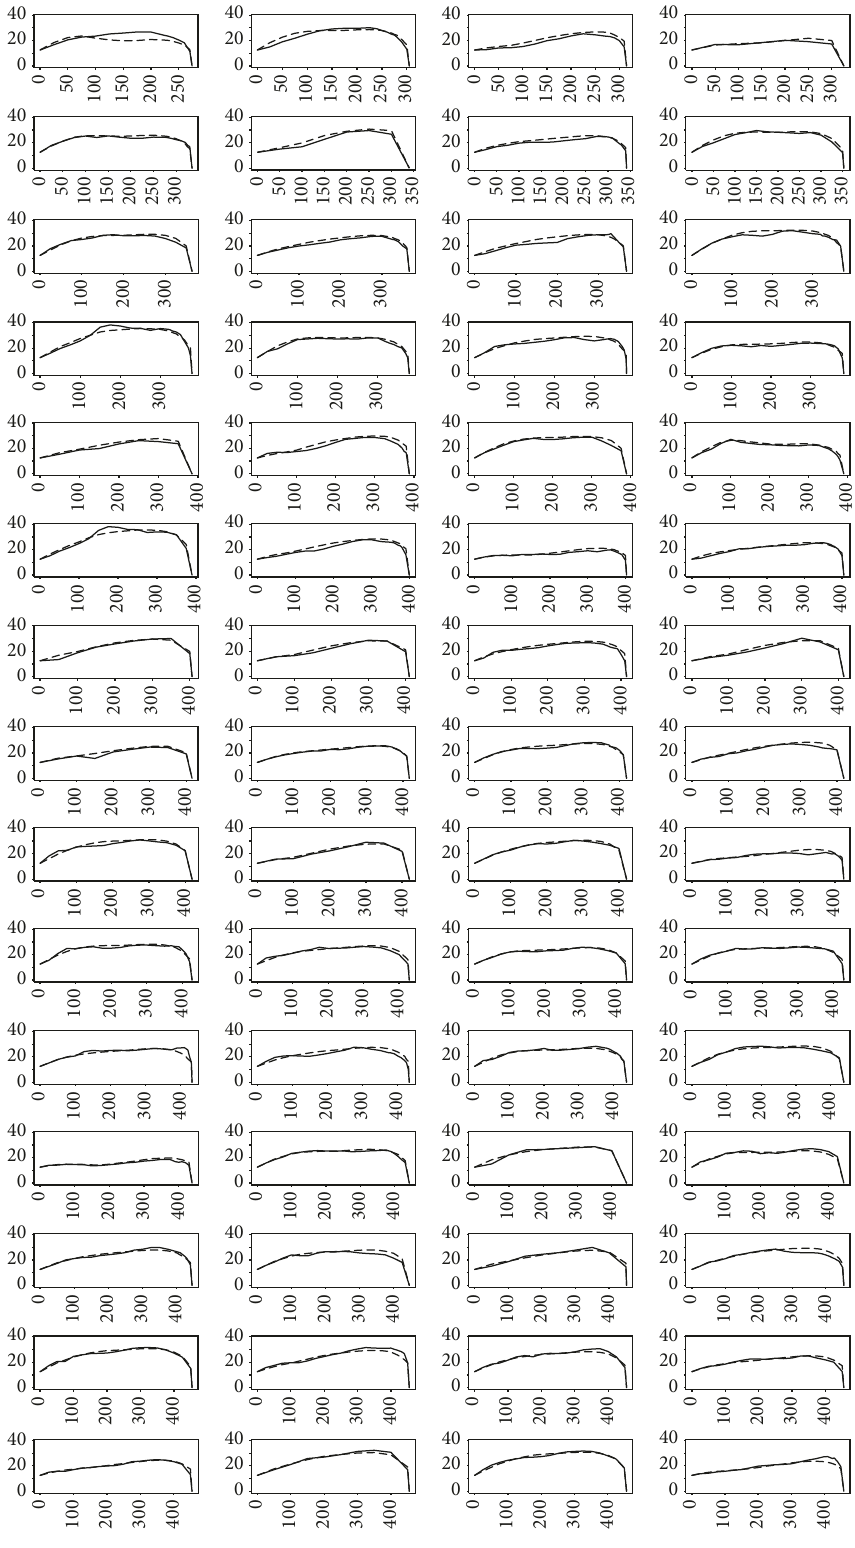
Figure8:Observations(solid)andpredictions(broken)fortheshapeofthesamples(numbers1–60,lengthof274to459 mm),usingproposed Bayesian method with M-RM prediction model. The samples are ordered by the length. The horizontal and vertical axes indicate the distance (mm) from the cutoff point and the radius (mm),